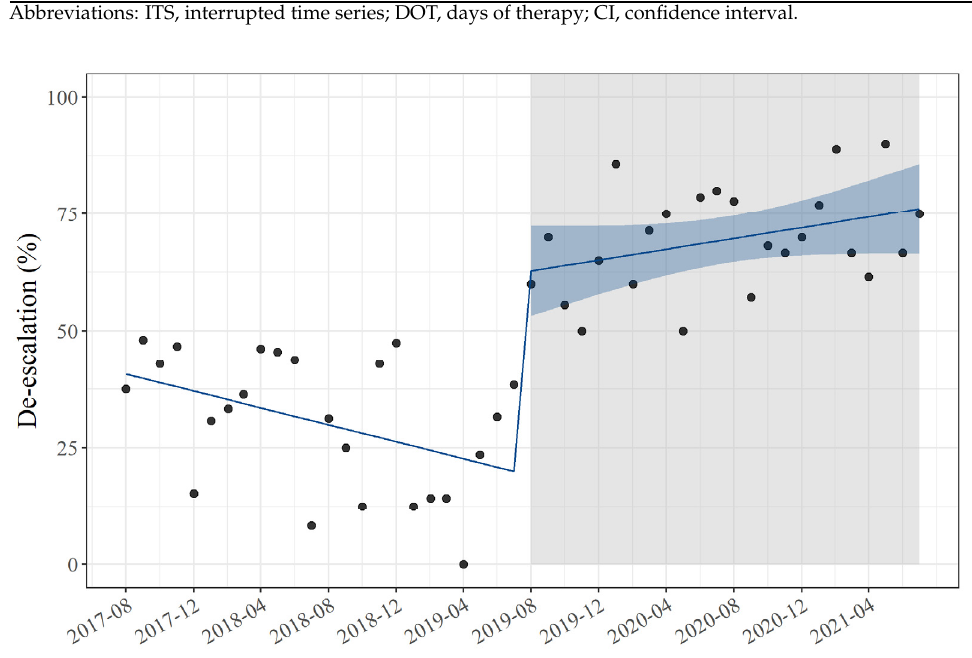
Figure 2. ITS analysis for the proportion of de-escalation. The gray area indicates the start of pharmacist-driven PAF. The dots indicate the measured values for each month, and the blue line indicates the regression line. The light blue band indicates 95% confidence interval. Abbreviation: ITS, interrupted time series; PAF, prospective audit with intervention and feedback.